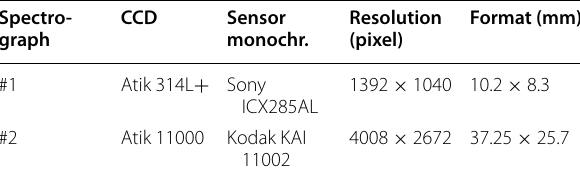
Table 1 Description of main features of the two CCDs used in the spectrographs Spectro‑